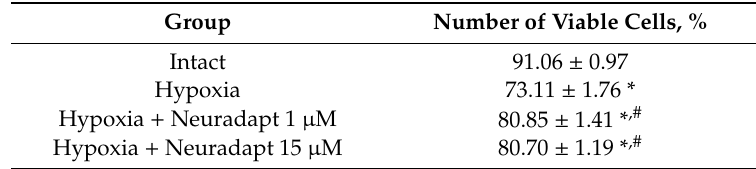
Table 3. Cell viability of primary hippocampal cultures on day 7 with daily neuradapt application started 2 h